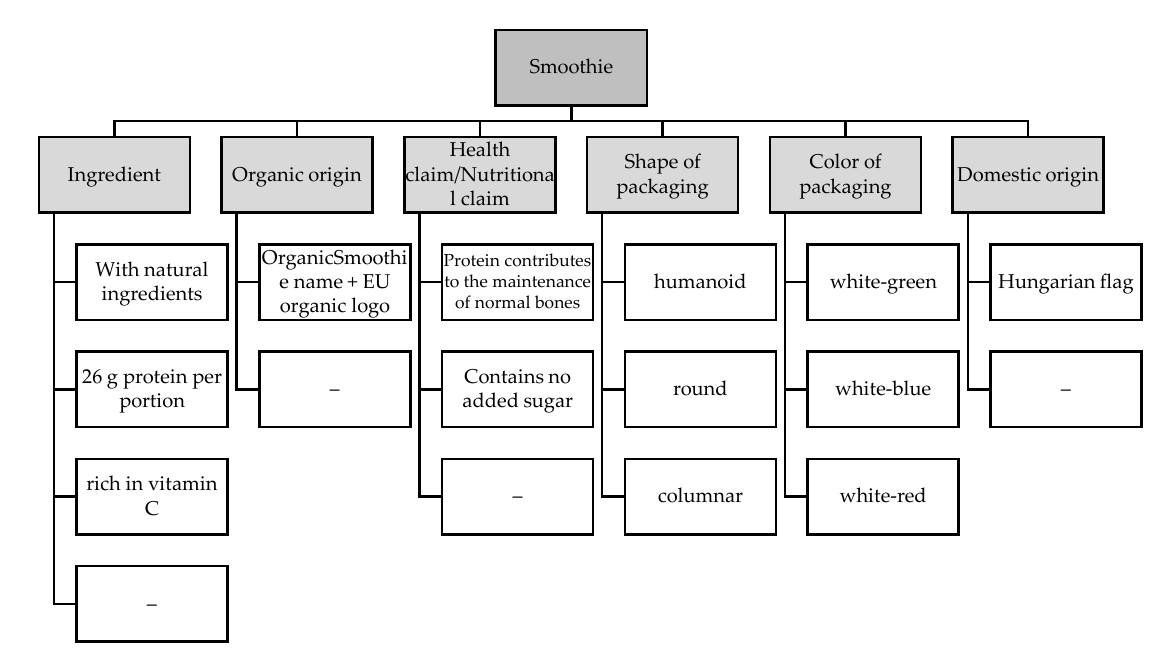
Figure 1. Summary of attributes and levels.